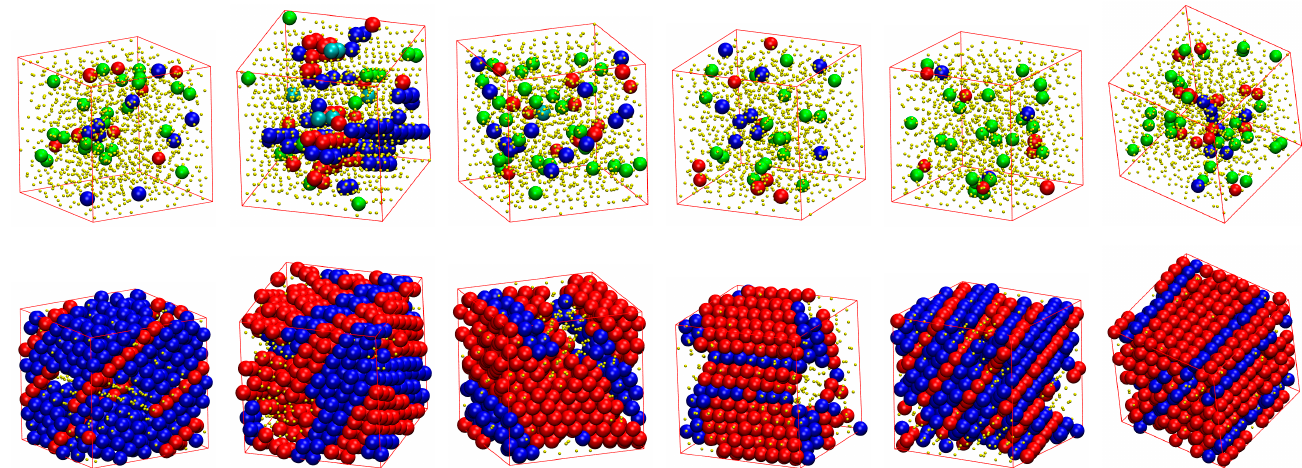
Figure 7. Snapshots of the initial ( top ) and final ( bottom ) configuration of the MC simulations for the 100-chains N av = 12 systems at ϕ = 0.59 of (from left to right) freely-jointed chains and semiflexible chains ( k θ = 9 ) with equilibrium bending angle θ 0 = 0, 60, 90, 108, and 120 ◦ . Monomers are color-coded according to CCE norm. Blue, red, cyan, purple, and green correspond to HCP-, FCC-, BCC, HEX-, and FIV-like sites, respectively. Amorphous (AMO) sites are colored in yellow and are shown with reduced dimensions for visual clarity. Individual panels are also available as stand-alone, interactive, 3-D images (in Supplementary